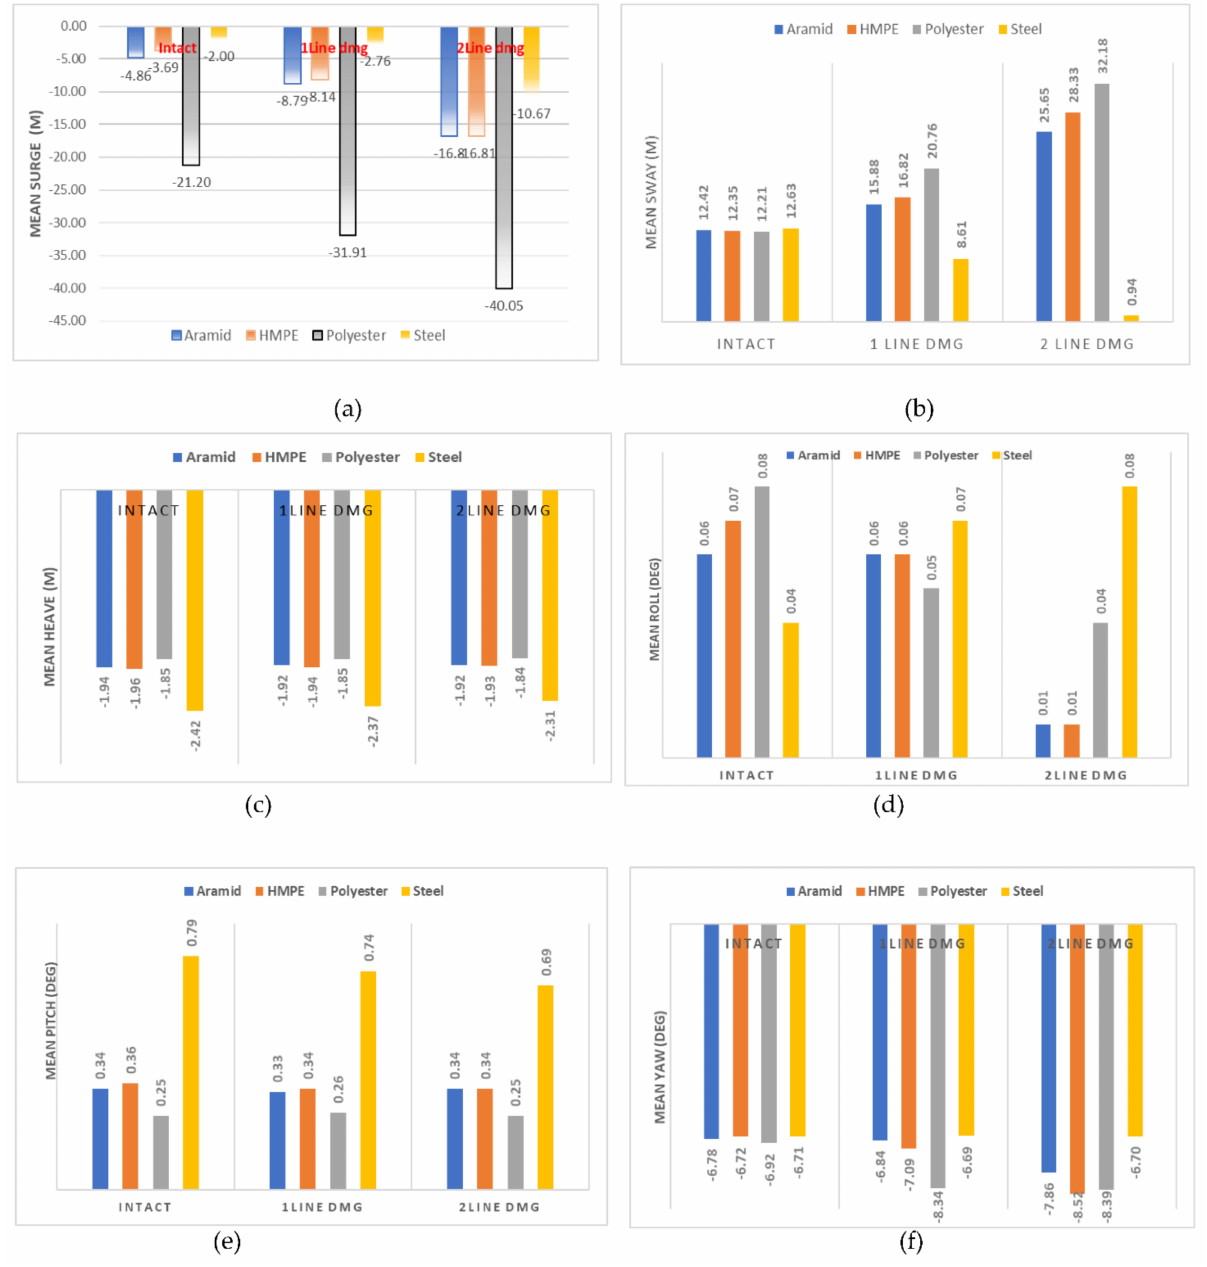
Figure 10. Statistical comparison of FPSO mean offset in 6 DOF considering mooring systems with different mooring materials in intact and damaged conditions: ( a ) mean surge; ( b ) mean sway; ( c ) mean heave; ( d ) mean roll; ( e ) mean pitch; ( f ) mean